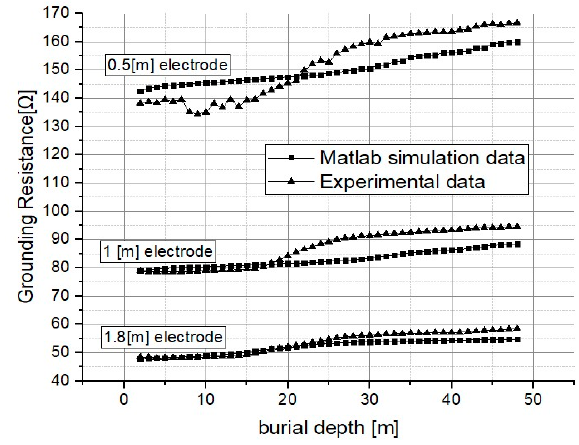
Figure 10. Theoretical and measured values of grounding resistance.